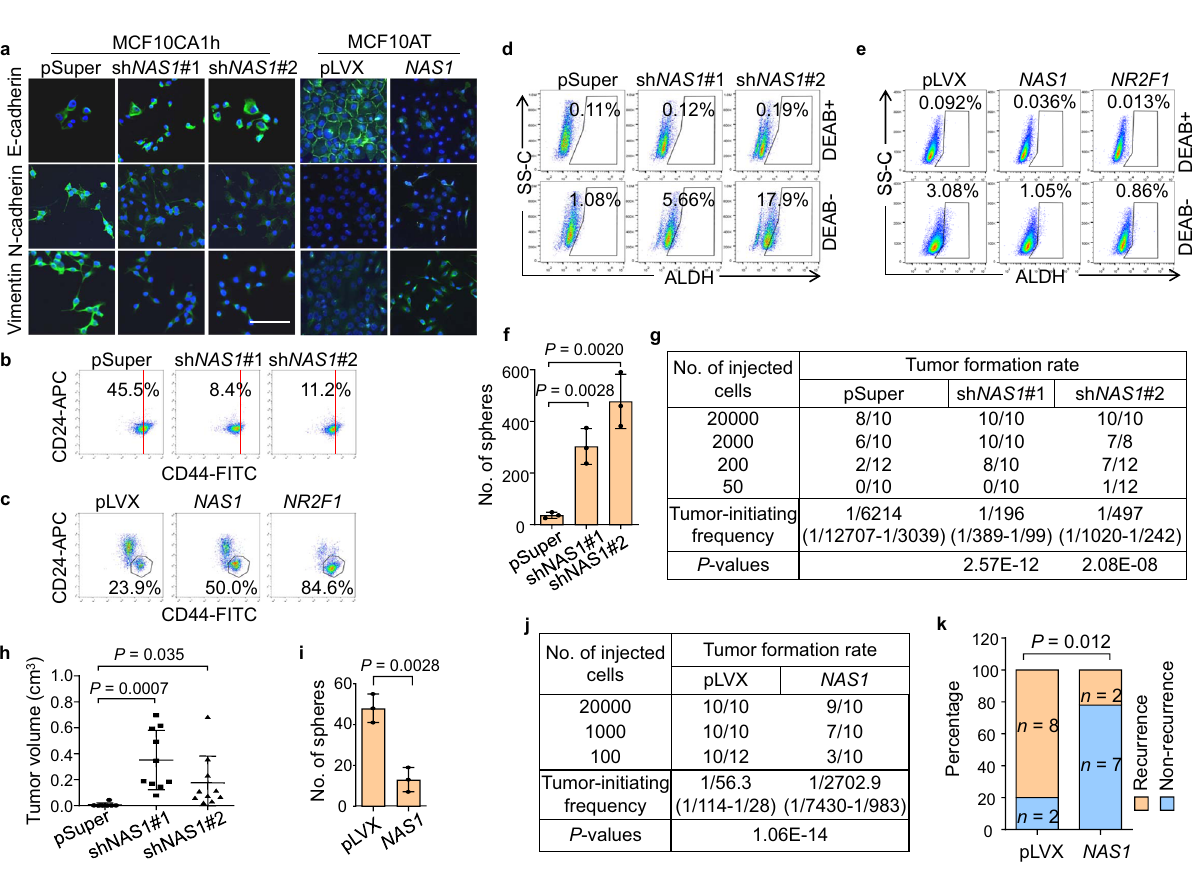
Fig. 3 NAS1 promotes EMT but inhibits tumorigenicity of breast cancer cells. a Representative IF images of EMT markers in CA1h-P2 with NAS1 knockdown (left) or MCF10AT with NAS1 overexpression (right). Scale bar, 100 μ m. Random microscopic fi elds ( n > 3) showed similar results. b , c Flow cytometric analyses of CD24/CD44 expression in CA1h-P2 with NAS1 knockdown ( b ), or MCF10AT with NAS1 or NR2F1 overexpression ( c ). Red vertical lines indicate the same abscissa value in different panels. Numbers denote the CD24 − CD44 + percentages. d , e Flow cytometric analyses of ALDH + BCSCs in CA1h-P2 with NAS1 knockdown ( d ) or in MCF10AT with NAS1 or NR2F1 overexpression ( e ). Numbers show the ALDH + percentages. DEAB, the ALDH inhibitor. f Tumorsphere formation of CA1h-P2 with NAS1 knockdown ( n = 3 culturing experiments). g Tumor incidence in NOD/SCID mice